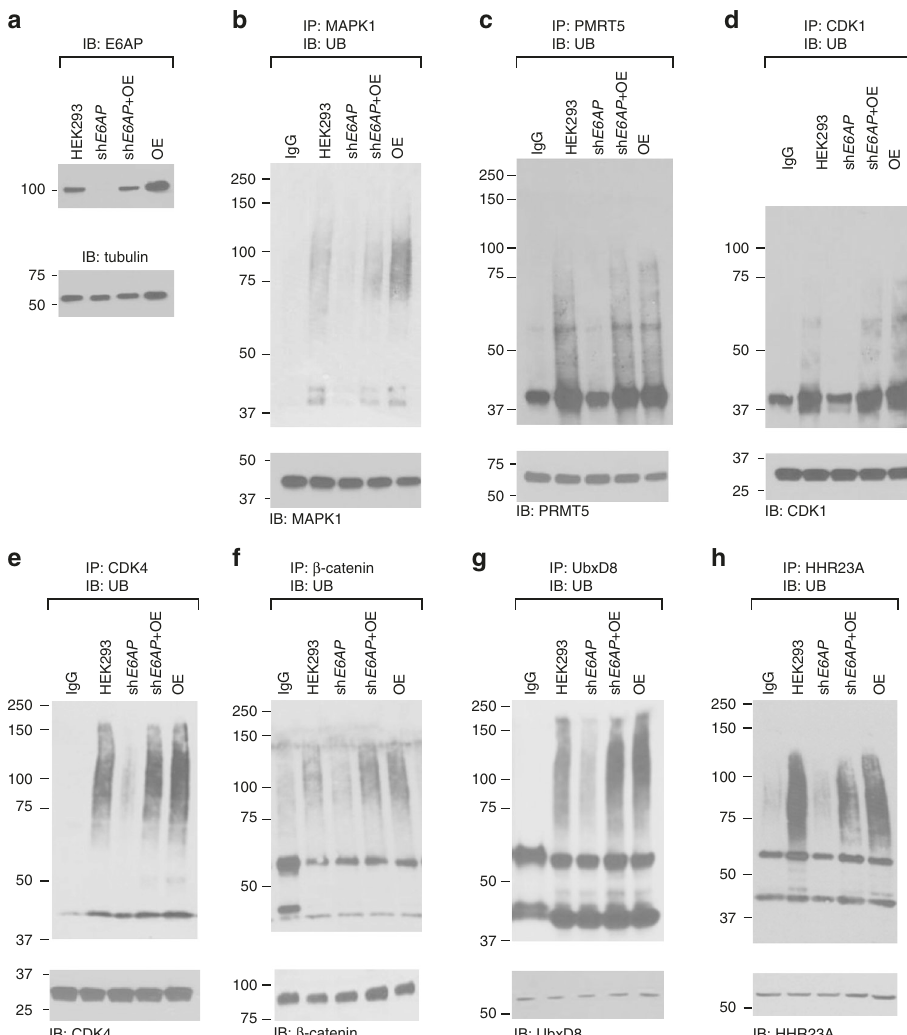
Fig. 6 Cellular assays to test the ubiquitination of E6AP substrates identi fi ed by OUT. a Inhibition of E6AP expression in HEK293 cells by sh E6AP was con fi rmed with Western blot probed with an antibody against E6AP. b – g Ubiquitination of MAPK1 b , PRMT5 c , CDK1 d ,CDK4 e , β -catenin f and UbxD8 g in HECK293 cells was assayed by immunoprecipitation with antibodies against each substrate proteins and probing the ubiquitination levels of the proteins with an anti-UB antibody on the western blots. After 1.5-h treatment of cells with MG132, ubiquitination of each target protein was compared among the blank HEK293 cell (HEK293), HEK293 expressing sh E6AP (sh E6AP ), HEK293 expressing both sh E6AP and recombinant E6AP (sh E6AP + OE), and HEK293 expressing recombinant E6AP (OE). h Ubiquitination of HHR23A, a known E6AP substrate, was assayed as a control. Rabbit IgG was used as a control for immunoprecipitation in b and e . Mouse IgG was used as a control for immunoprecipitation in c , d and f – h . All blots are representative of at least three independent